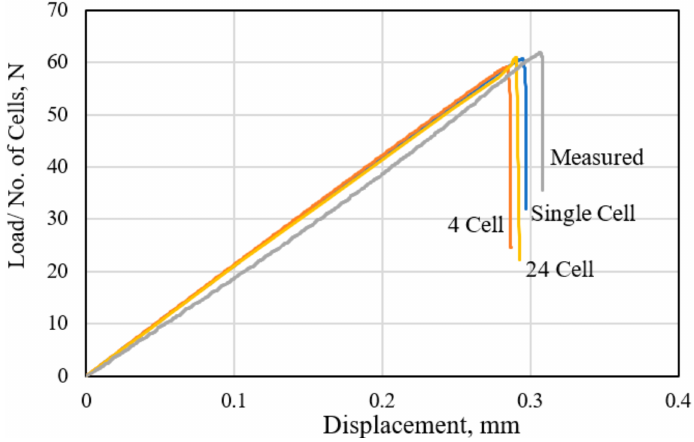
Figure 6. Comparison of FE-calculated and measured tensile responses of the HC